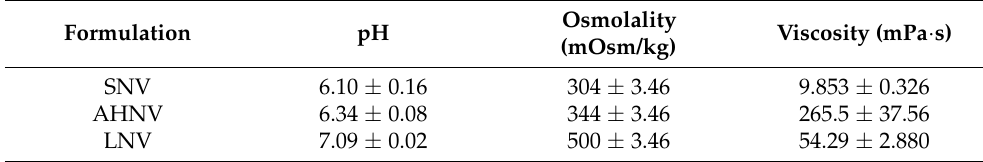
Table 6. pH, osmolality, and viscosity results.